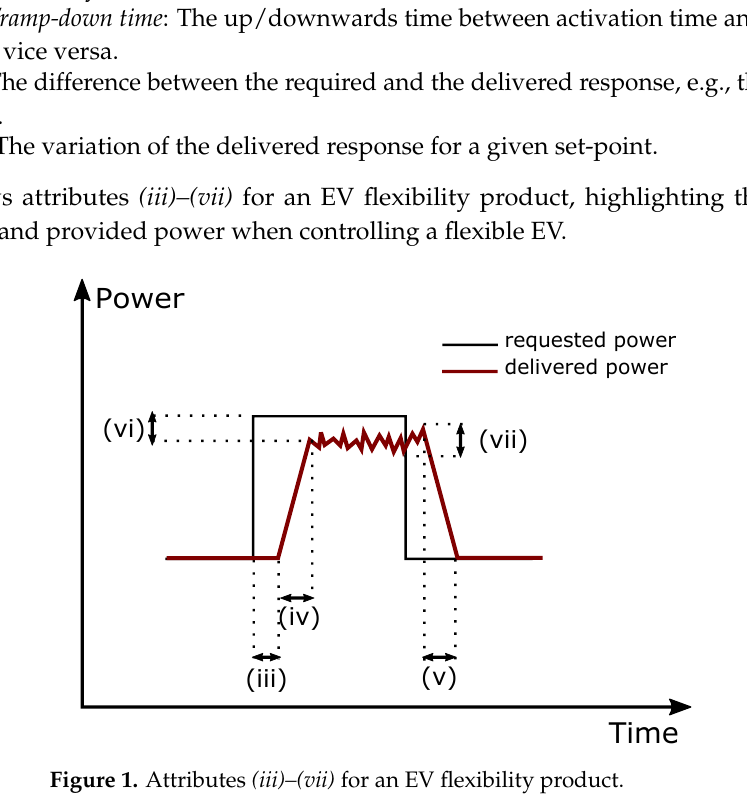
Figure 1. Attributes (iii)–(vii) for an EV flexibility